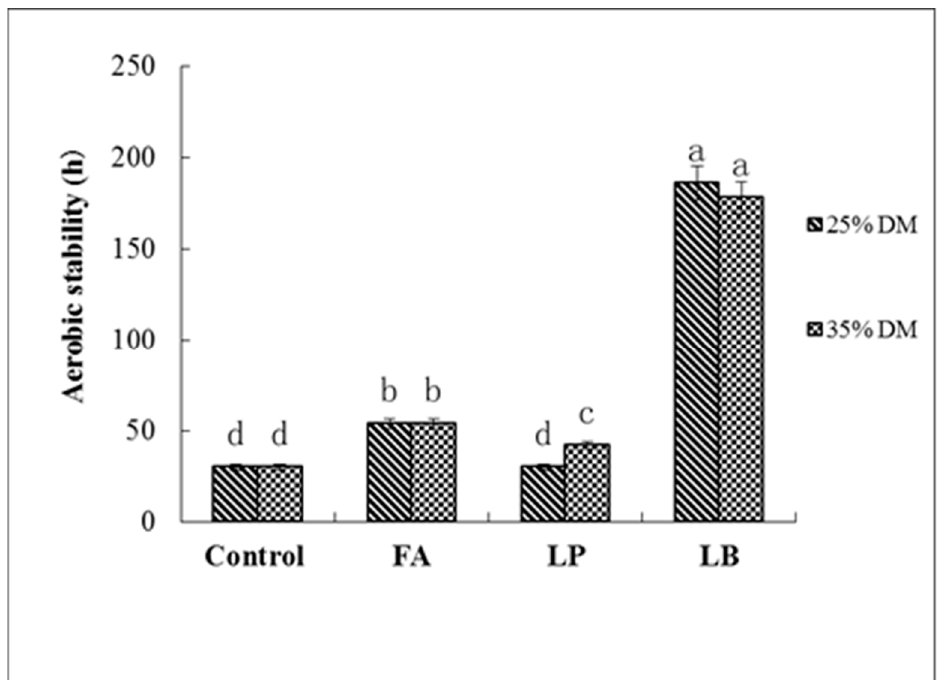
Figure 1. Effect of different additives on aerobic stability of Italian ryegrass silages ensiled at different DM contents. FA, formic acid; LP, Lactobacillus plantarum ; LB, Lactobacillus buchneri . a–d means with different letters differ ( p < 0.05). Error bars indicate the standard error of mean values (n = 3).